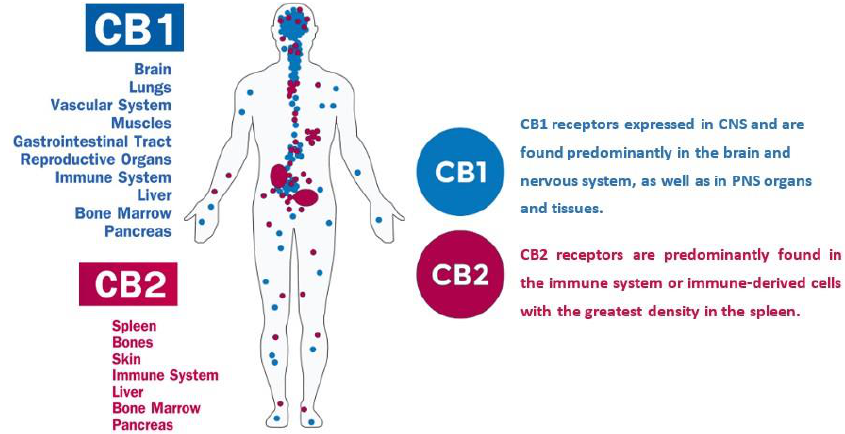
Figure 2. Cannabinoids receptors CB1 and CB2 and their natural distribution in the human body.